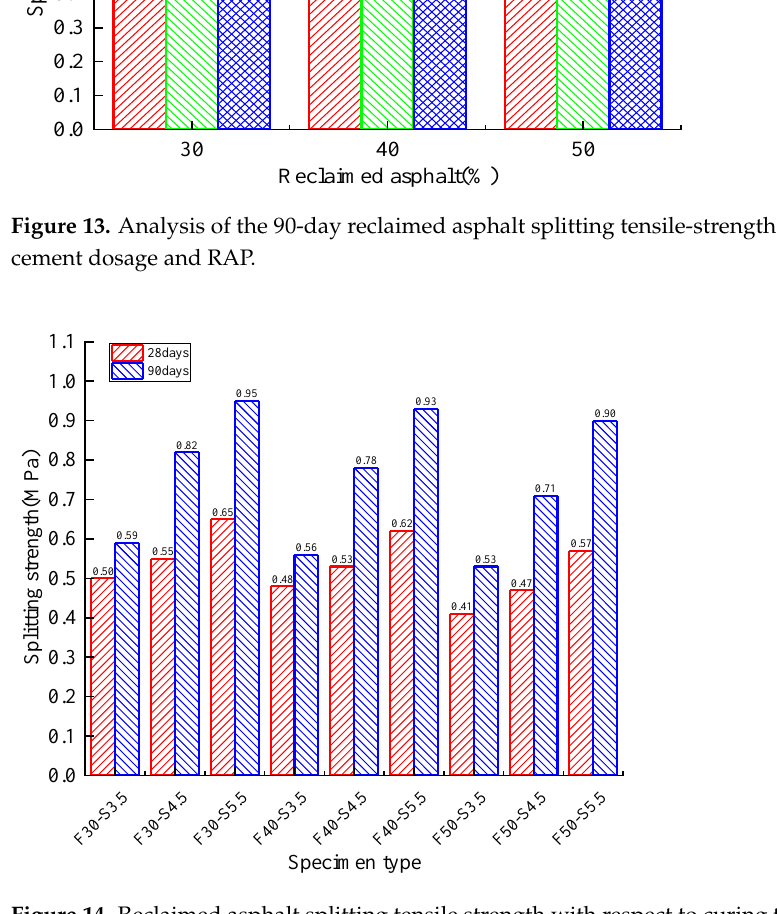
Figure 14. Reclaimed asphalt splitting tensile strength with respect to curing time.